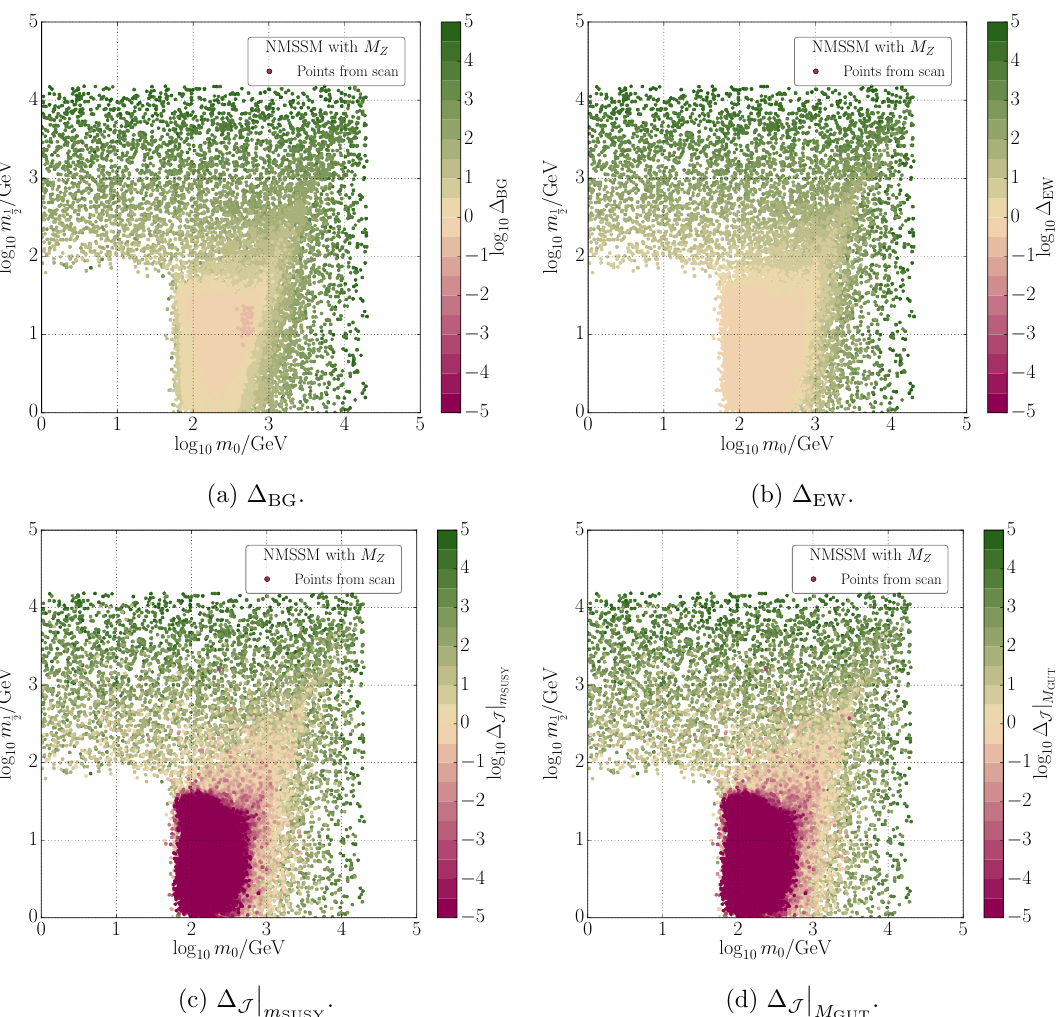
Figure 8. Comparison of (cid:12)ne-tuning measures in the NMSSM on the ( m 0 , m de(cid:12)nitions, see section 4.3.